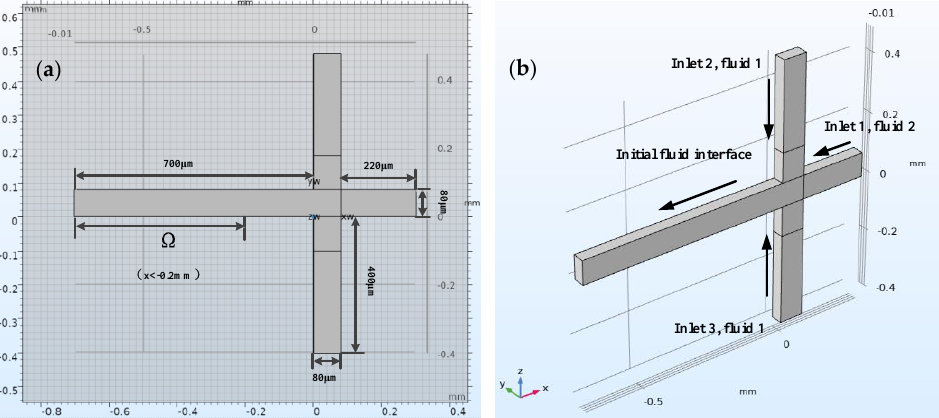
Figure 2. The top view of the flow focusing structure and effective droplet diameter solution area Ω ( a ). 3D model of flow focusing microchannel showing the inflow fluid for each inlet ( b ).